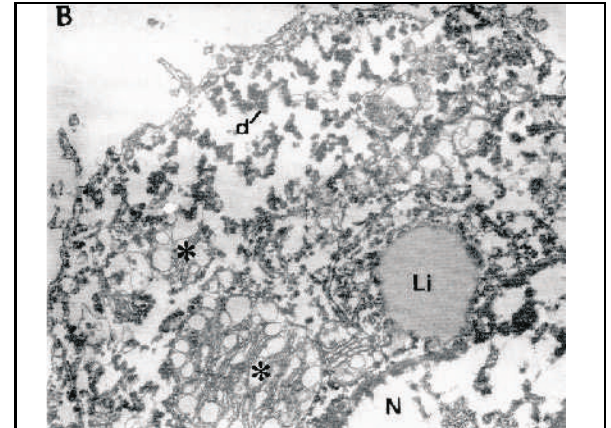
FIGURA 4a – Elétron-micrografia de células tumorais de Ehrlich do grupo tratado com 0,50 ml S.T. – Aspecto geral da célula tumoral: Núcleo (N) eletrolucente com massas densas, citoplasma com estruturas membranosas (l ) e massa de material denso floculado (d). Notar a manutenção das pequenas projeções filiformes (p) da superfície celular.X 10.000.